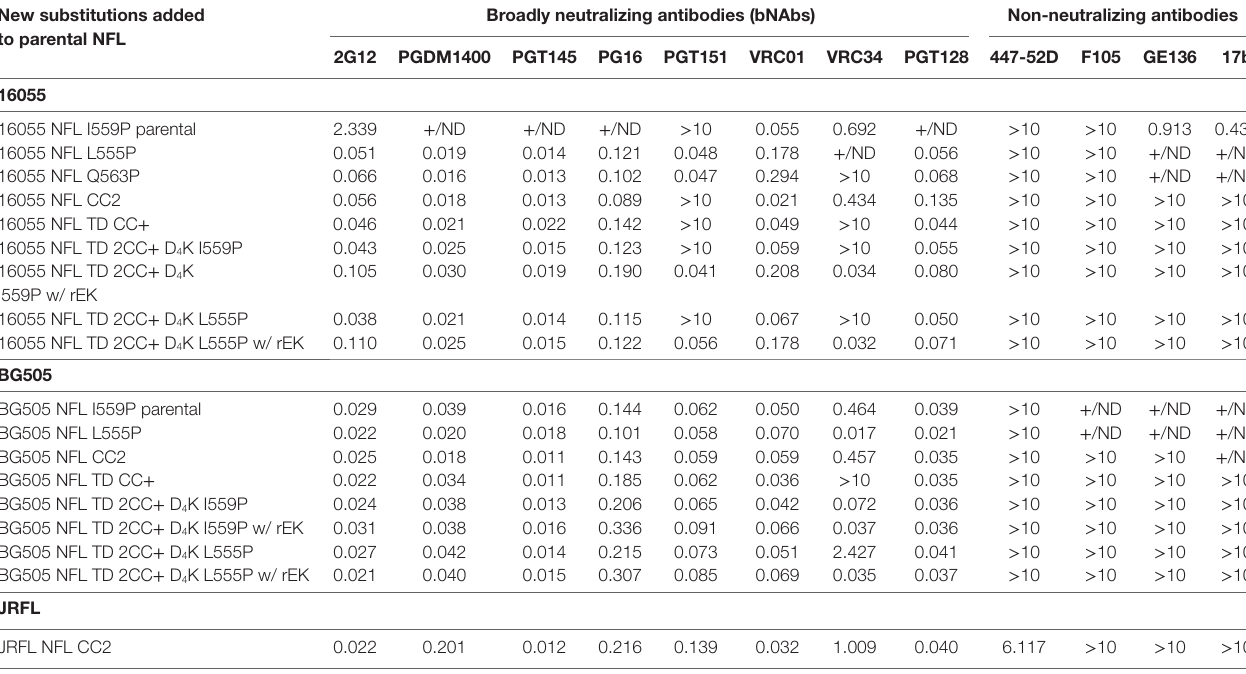
Binding of bNAbs and non-NAbs was determined using a His-tag capture ELISA. Half-maximal binding concentrations (EC 50 , in µg/ml) are shown in the table. The values are representative of at least two independent experiments. The ELISA curves from one representative experiment are shown in Supplementary figures. + /ND, indicates that the binding reactivity was positive but was not high enough to reliably determine an EC 50